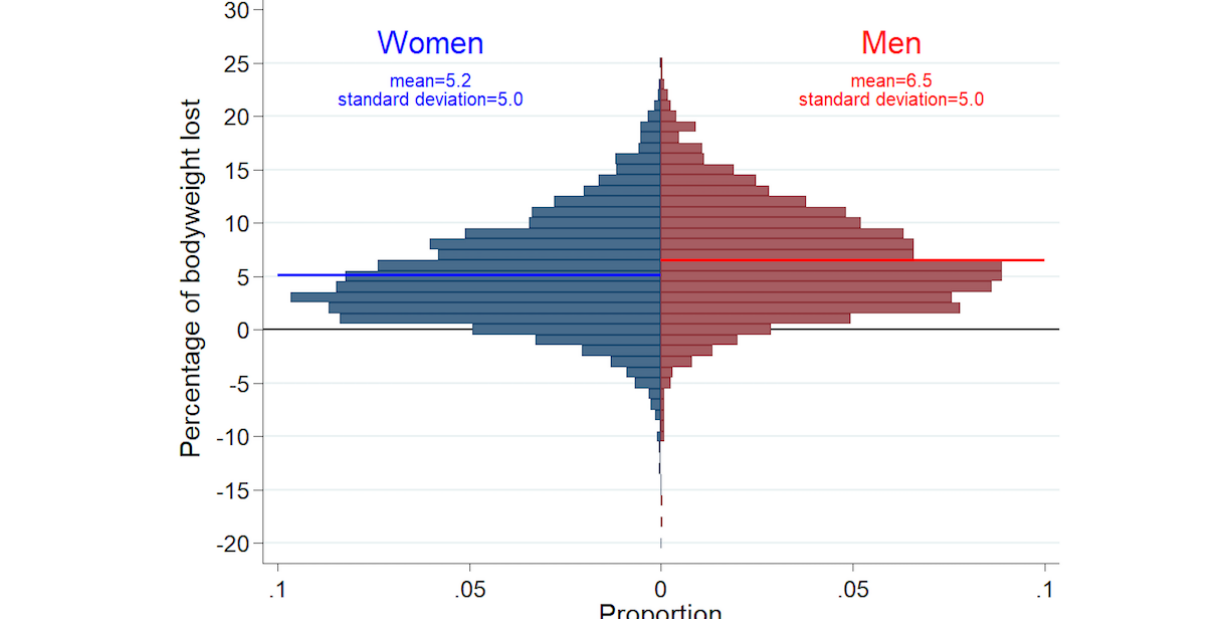
Figure 3. Distribution of percentage of bodyweight lost for women (n=4702) and men (n=2305) who used the Lose It! mobile phone